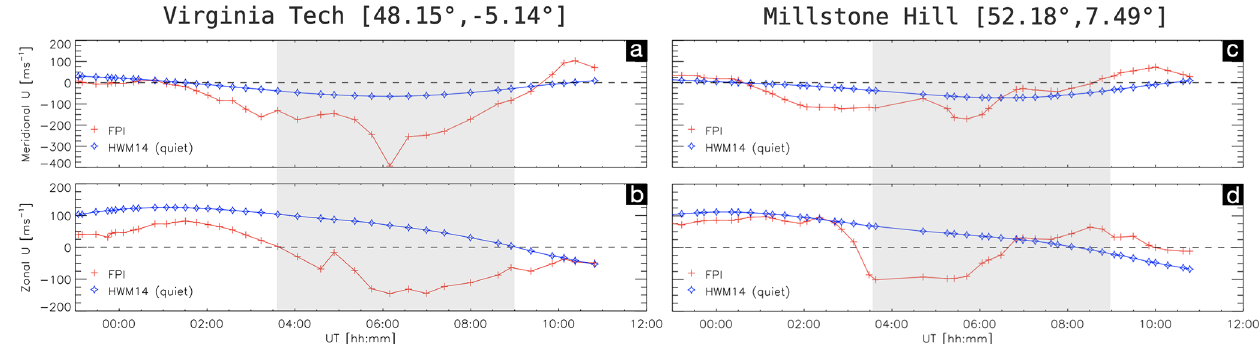
Figure 3. Time series of neutral wind zonal (a, c) and meridional (b, d) velocities at the locations of VTI (a, b) and MH (c, d) FPIs starting at 20:00UT on 8 November and ending at 12:00UT on 9 November 2013. Red lines are velocities from the FPIs with error bar uncertainties, while blue lines with diamonds are the quiet time curve from the HWM14. The grey shaded region is the geomagnetic storm main phase, also shown in Fig. 2. Positive values are poleward and eastward for the meridional and zonal data,